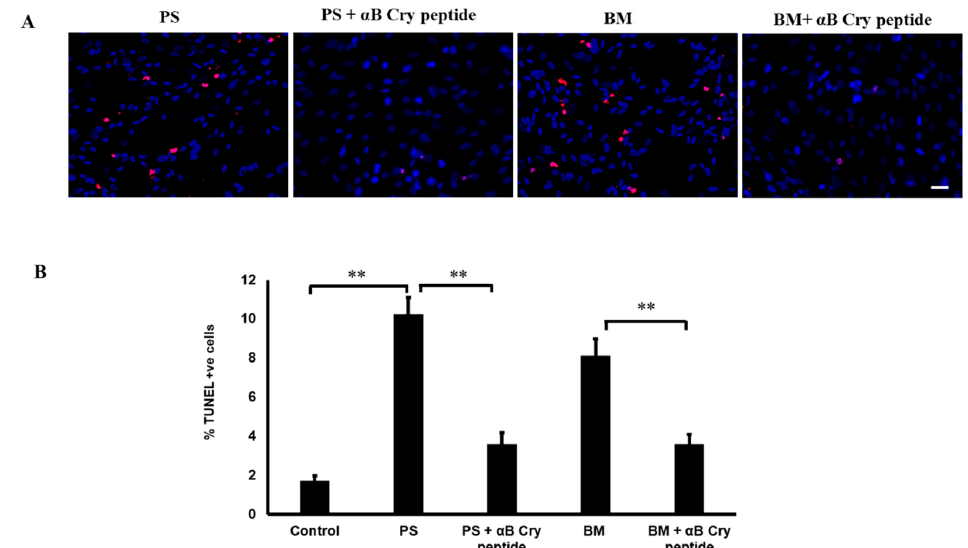
Figure 1. Increased RPE apoptosis with pharmacological inhibition of mGSH transporters OGC and DIC and attenuation of apoptosis by α B cry peptide treatment. ( A ) Primary cultured hRPE cells were treated with PS (5 mM) or BM (5 mM) with and without α B cry peptide (75 µ g / mL) for 24 h. Apoptosis was determined by TUNEL staining (red). Nuclei were stained with DAPI (blue). ( B ). Quantification of TUNEL-positive cells is shown as % over controls. Co-treatment with α B cry peptide significantly attenuated RPE cell apoptosis caused by inhibition of mGSH transporters. Data are mean ± SEM. n = 3; ** p < 0.01; Scale bar: 50 µ m. mitochondrial glutathione (mGSH), human retinal pigment epithelium (RPE), Phenylsuccinic acid (PS), Butylmalonic acid (BM). To further confirm the findings obtained with pharmacological inhibitors, inhibition experiments after OGC silencing were performed. Cells in which OGC were silenced >75% (vs. control) were used for this purpose. OGC silencing rendered RPE cells susceptible to cell death as observed with chemical inhibitors (Figure 2 A, B) and treatment with α B cry peptide significantly ( p < 0.01) inhibited cell death (Figure 2 A, B).